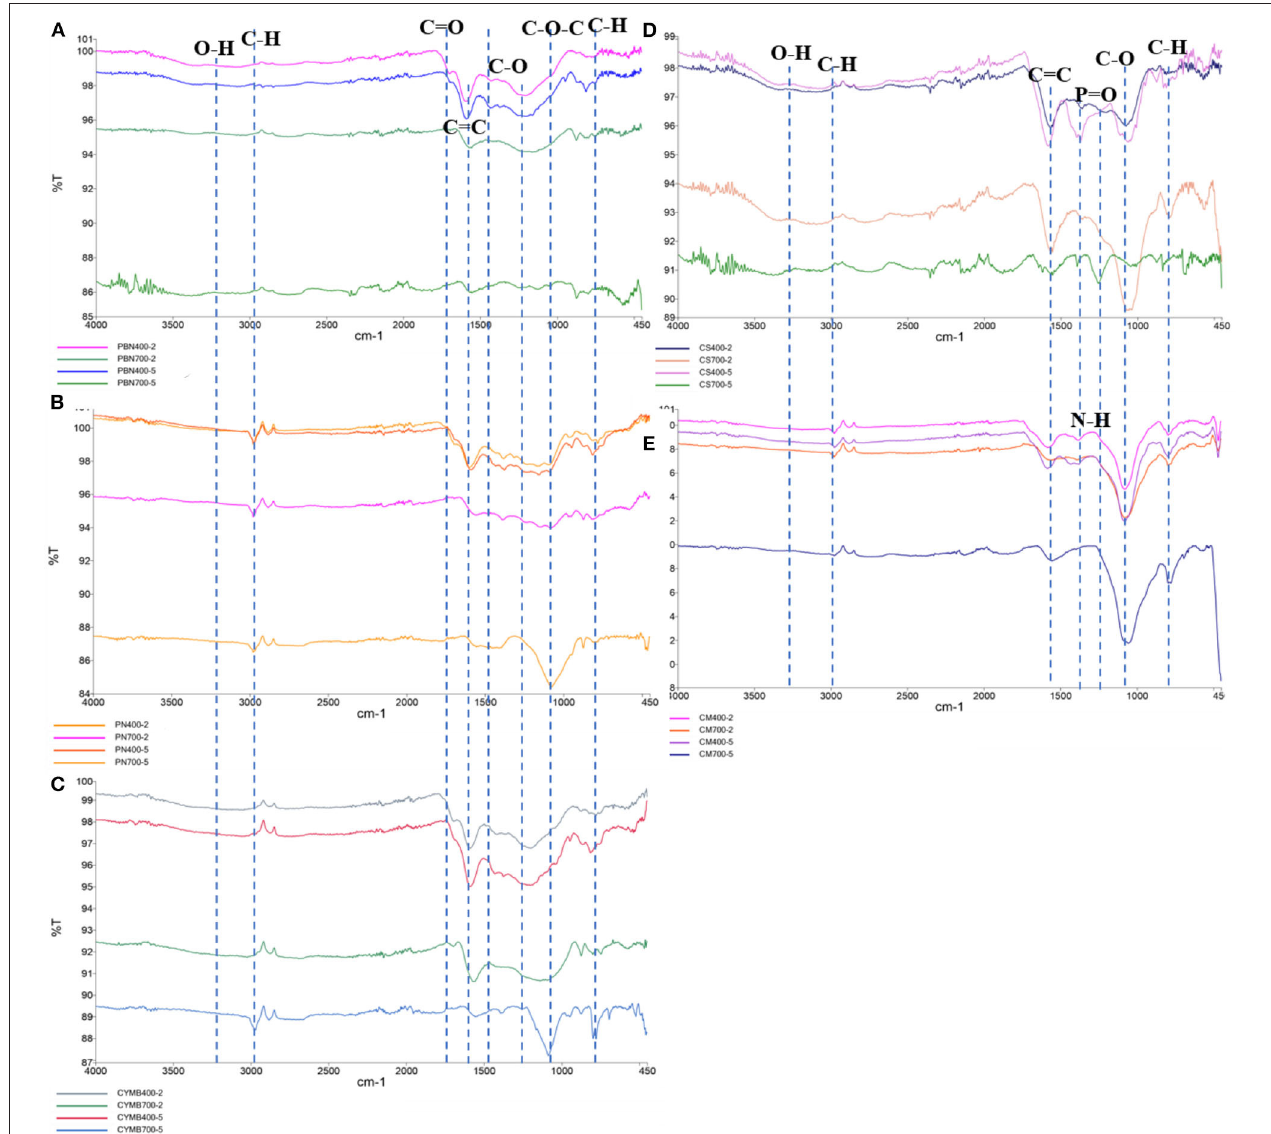
FIGURE 3 | FTIR analysis of functional groups of 20 types of biochar made from (A) pine bark, (B) pine needle, (C) cypress mulch, (D) corn stover, (E) cow